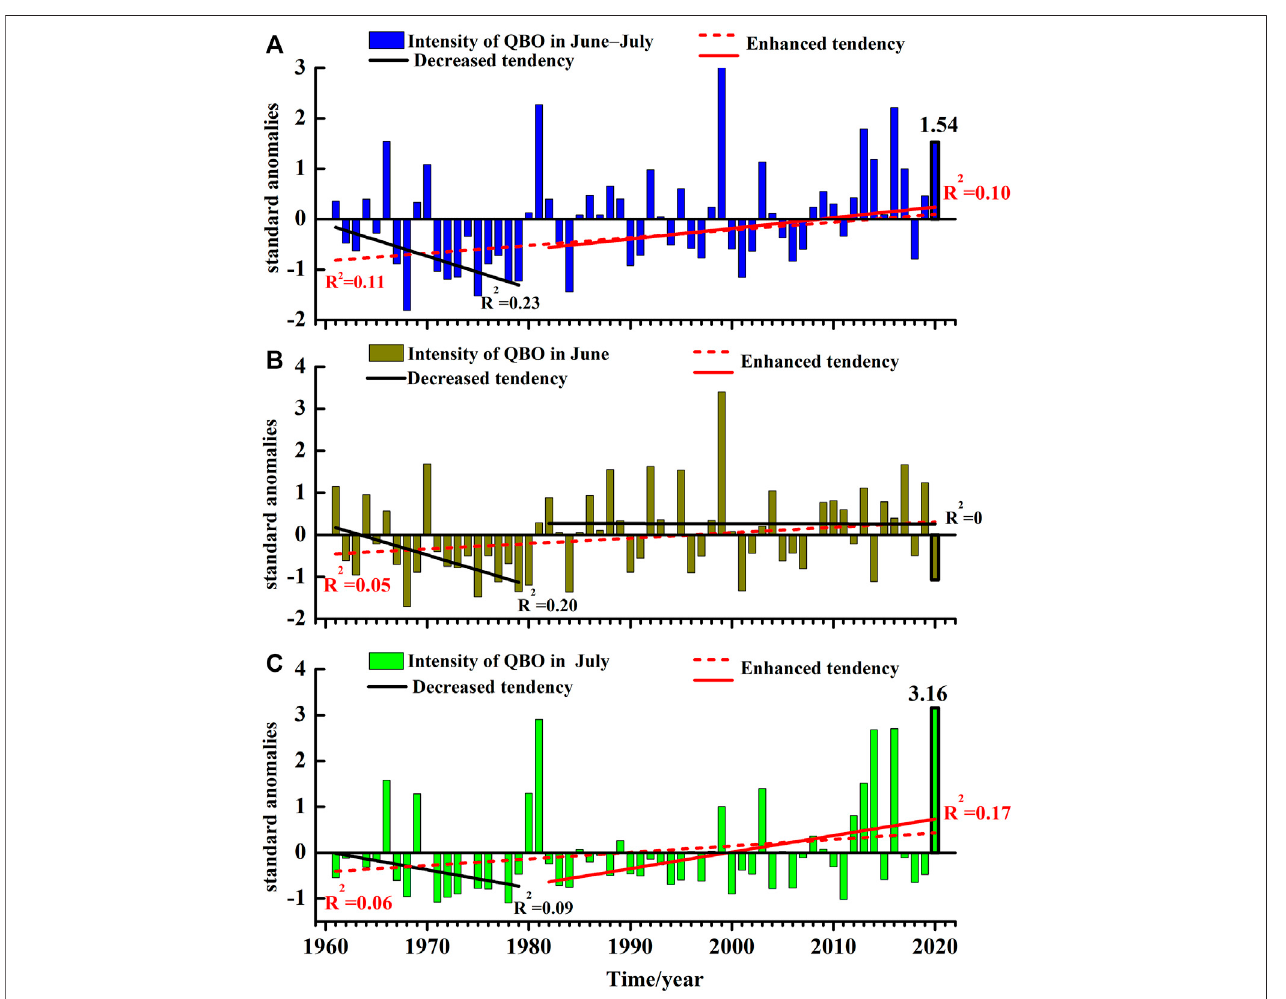
FIGURE6|(A) Interannualstandardizedanomaliesofintensityofquasi-biweekly(8 – 16 days)oscillation(QBWOI)ofprecipitationofJuneandJuly(bars)from1961 to 2020. Red dotted line is tendency of interannual series from 1961 to 2020. Solid lines are tendency of interannual series of 1961 – 1979 and 1982 – 2020. Red/black dotted line represents enhanced/decreased tendency. R 2 in left side of line is coef fi cient of determination of tendency of time span from 1961 to 2020. R 2 in right side is that of time span of 1961 – 1979 and 1982 – 2020. Value in 2020 is labeled. (B) as in (A) but for June. (C) as in (A) but for July.